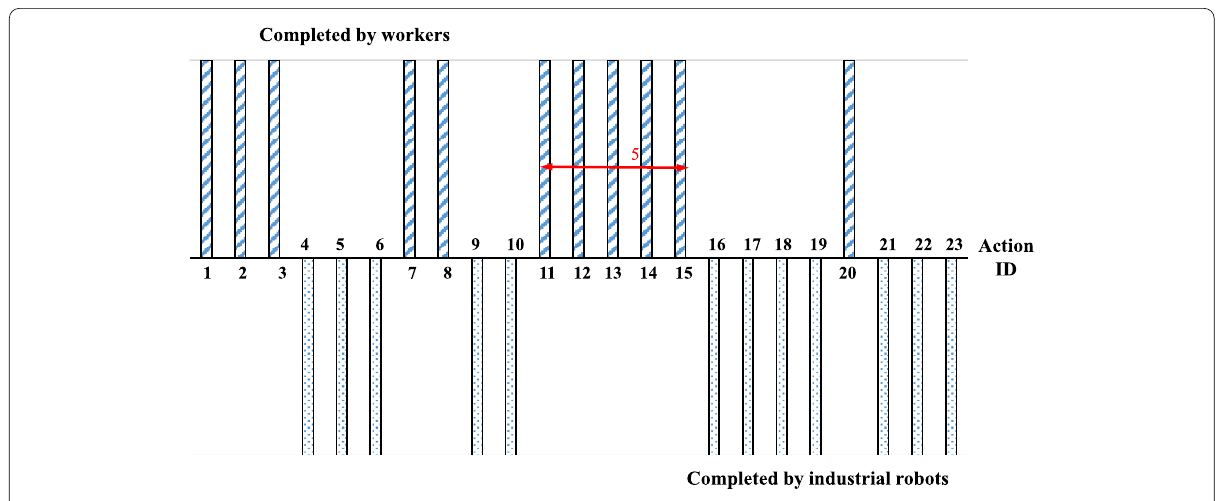
Figure 11 Human–robot collaboration